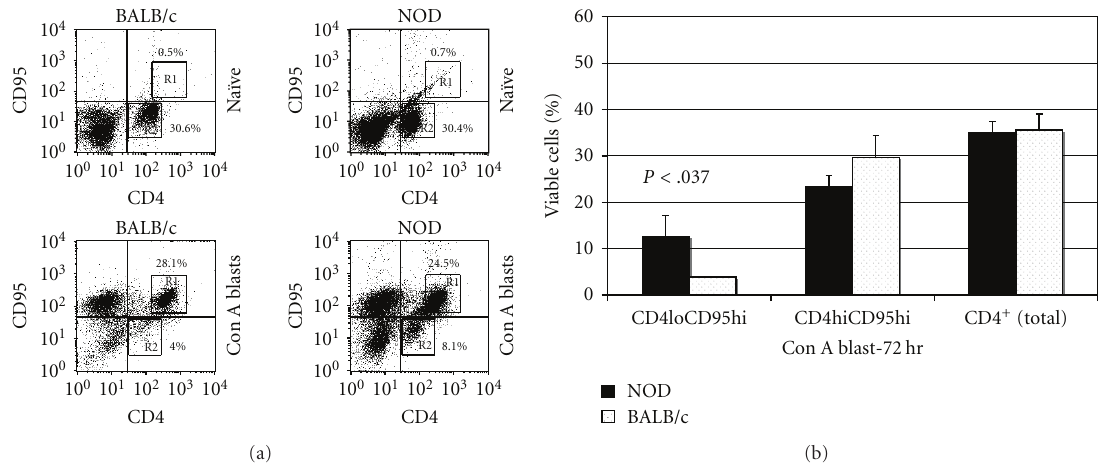
Figure 8: CD95 is poorly expressed on antigen-experienced CD4lo T cells. (a) Na¨ıve and Con A activated spleen cells pooled from two NOD or BALB/c mice were stained with anti-CD4 and CD95. R1 denotes region of double positive cells, CD4hiCD95hi, in Con A blasts. R2 denotes the region of single positive cells, CD4loCD95( − ). Twenty-thousand events were collected for the analysis. The numbers indicate the percentage of the total population that resides in R1 or R2. (b) A summary of 3 experiments performed as in (a), representing the mean and SD from 3 individual mice. The P -values are only displayed for those comparisons between NOD and BALB/c that were below